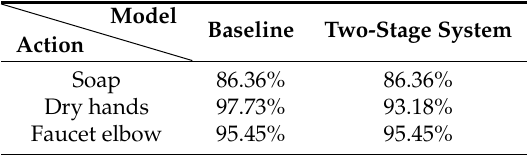
Table 10. Two-stage system: Average detection